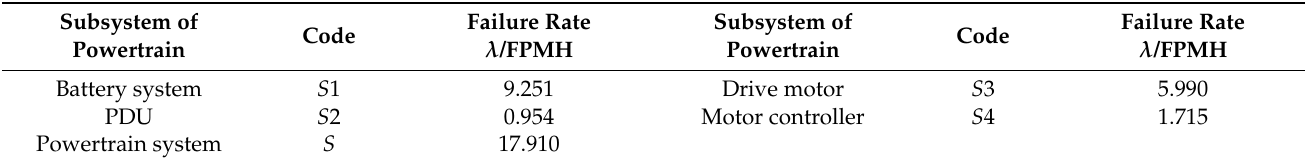
Table 4. Failure rates of powertrain system and its